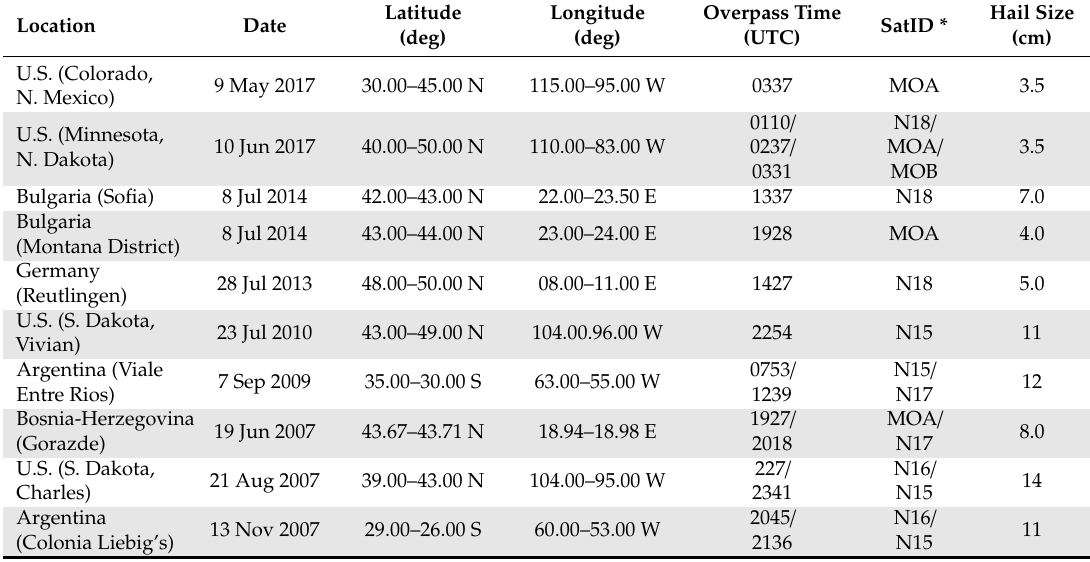
Table 1. List of the hailstorms used in the